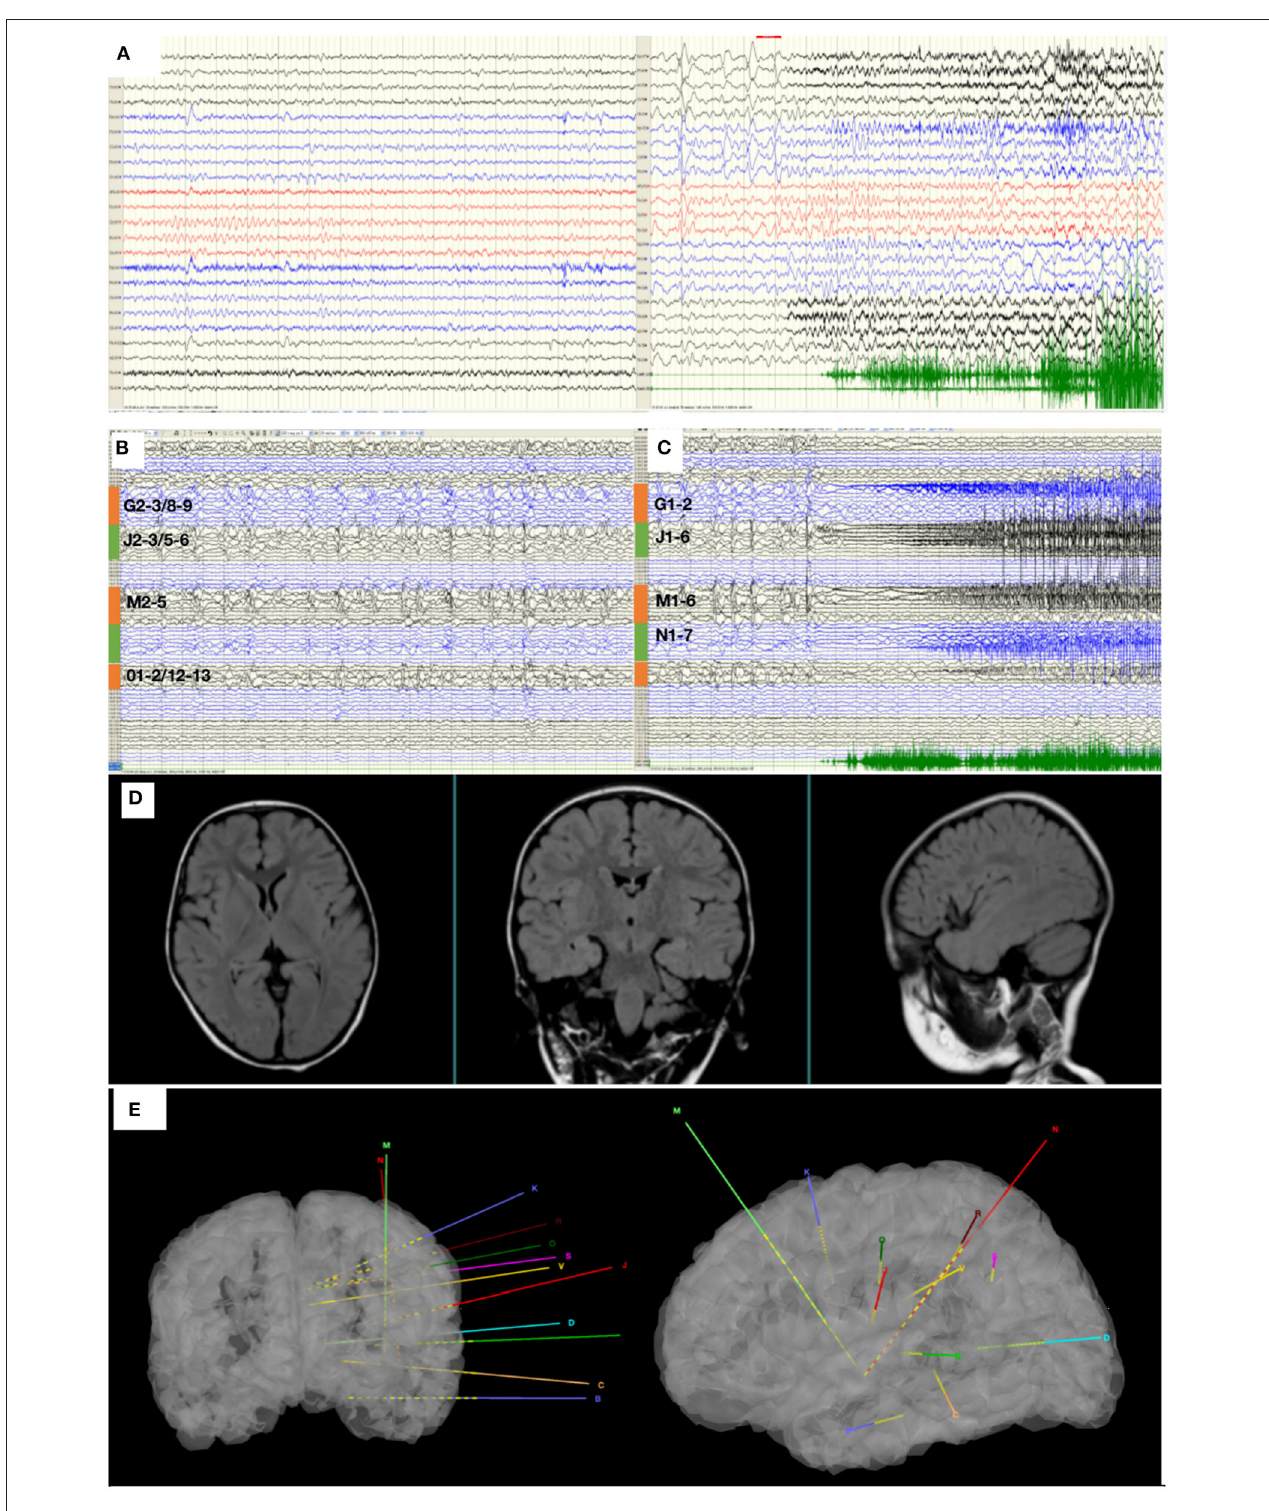
FIGURE 1 | (A) The interictal and ictal scalp VEEG. Scalp VEEG showed seizure onset with stiffening of right limb, apnea, salivation, waving of left limb. (B) SEEG showed all the inter-ictal discharges were located in insular-opercular cortex (J2-3/5-6, M2-5, G2-3/8-9, 01-2/12-13). (C) SEEG showed that the seizures onset zones originated from the insular-opercular cortex (J1-6, G1-2, M1-6, N1-7) with spike-wave in fast activities. The Semiology is stiffening of right limb, apnea, salivation, waving of left limb. (D) MRI images of the patient before the first intracranial electrode implantation. (E) The position of twelve electrodes.